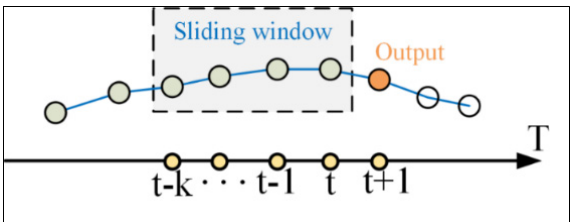
Figure 7. Sliding window procedure to obtain input–output pair of data sets. As shown in Table 3, the training rate is improved by using a batch training method, with each batch containing 40 sample data sets. In addition, a random dropout layer is added after each layer of the LSTM network with a dropout rate setting as 0.1 to avoid overfitting. Next, the root mean squared error ( RMSE ) is chosen as the loss function for training, and the Adam algorithm is used to train the network. The number of maximum iterations (epoch) is set to 400. Table 3. Key parameters of the model and training process. Key Parameters